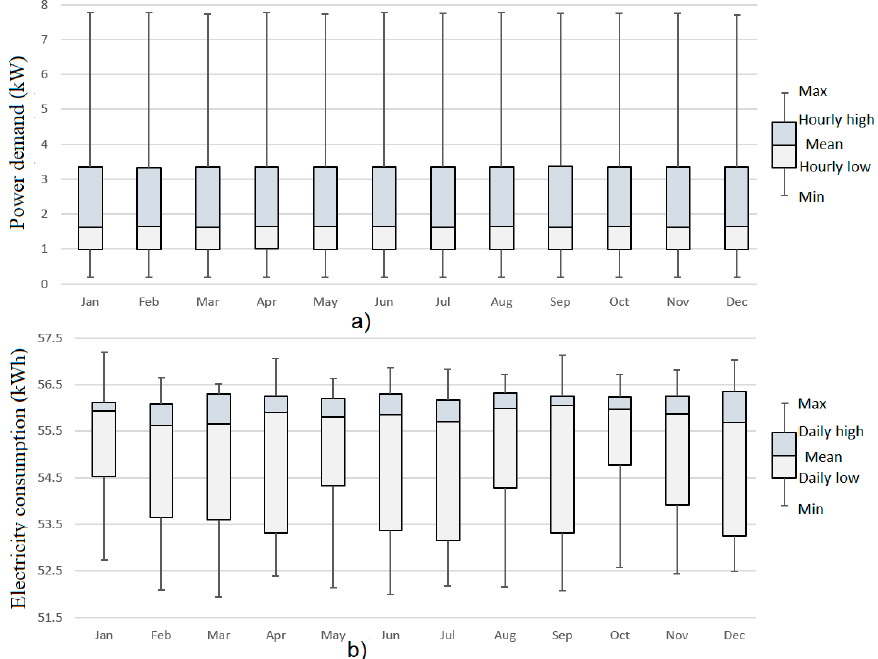
Figure 3. Characteristics of the electrical load during the first year: ( a ) Hourly power demand by month, ( b ) daily electricity consumption by month.